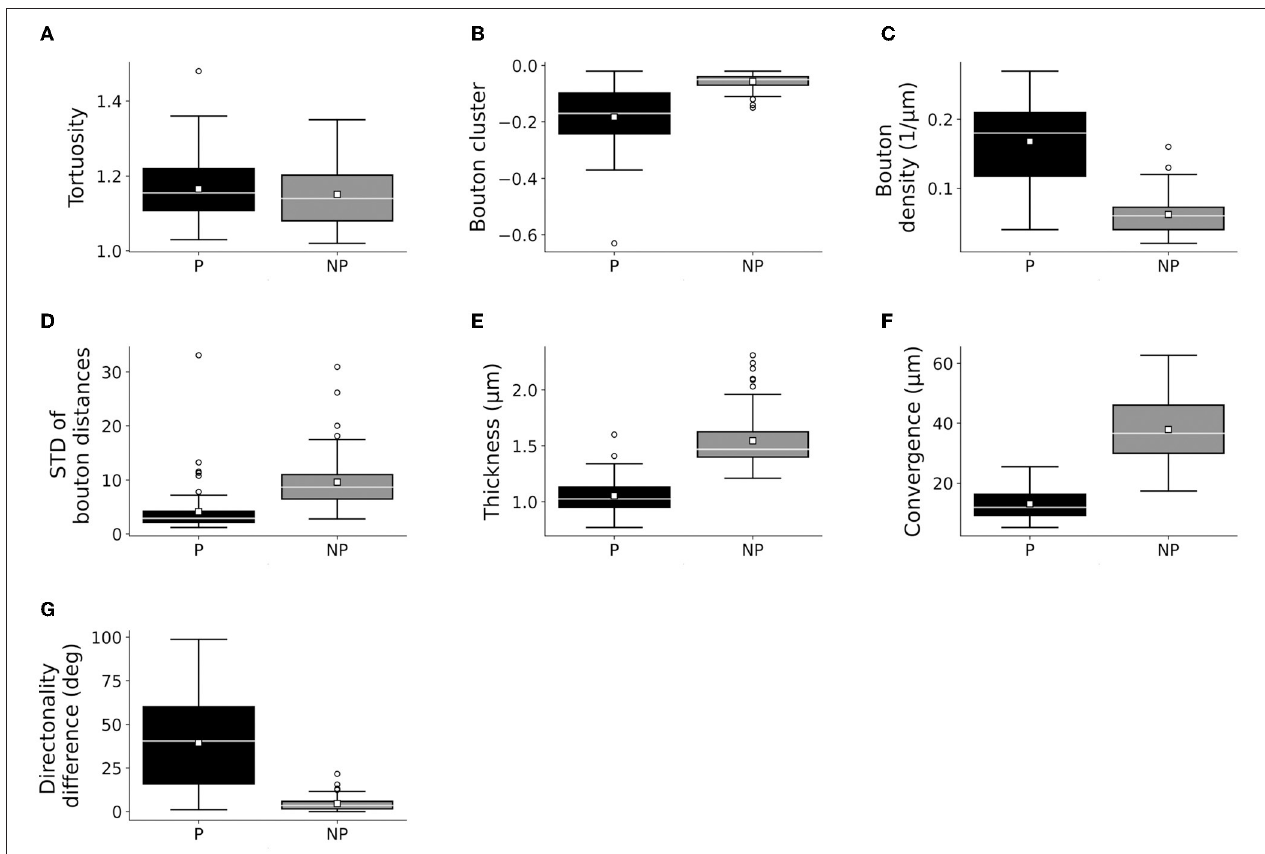
FIGURE 3 | Box plots of measured bouton and axonal characteristics of patch (P: 72) and no-patch (NP: 72) axons. (A) Tortuosity (the first 40 µ m segment of the axons beginning with the starting point), (B) bouton clustering (lower values indicate higher clustering), (C) bouton density, (D) bouton distance SD (SD of interbouton intervals along axons), (E) thickness, (F) convergence (or bouton-convergence, the distance of a bouton of a reconstructed axon from the two nearest boutons of unconnected axons), and (G) difference of the directionality of the axonal segments. Here and in the following plots, panels (A,E) show individual axonal properties and (F,G) presents collective axonal properties. Horizontal line: median, small square: mean, box: 25–75%, whiskers: non-outlier range, Circles: outliers representing data > 1.5 × height of the